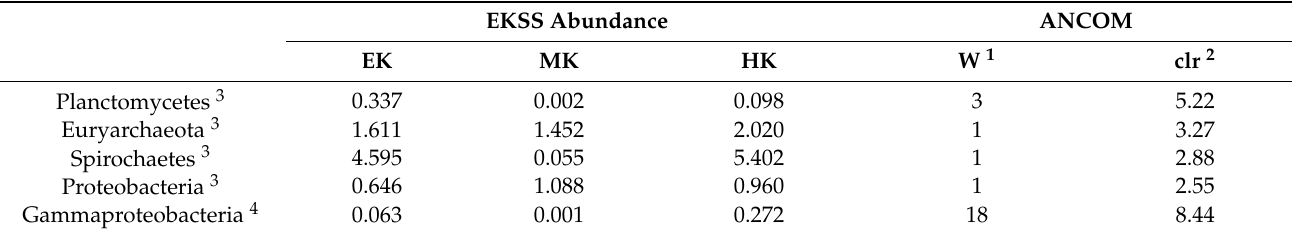
Table 4. Relative abundances of the ANCOM identified taxa to be differentially abundant between EKSS groups.